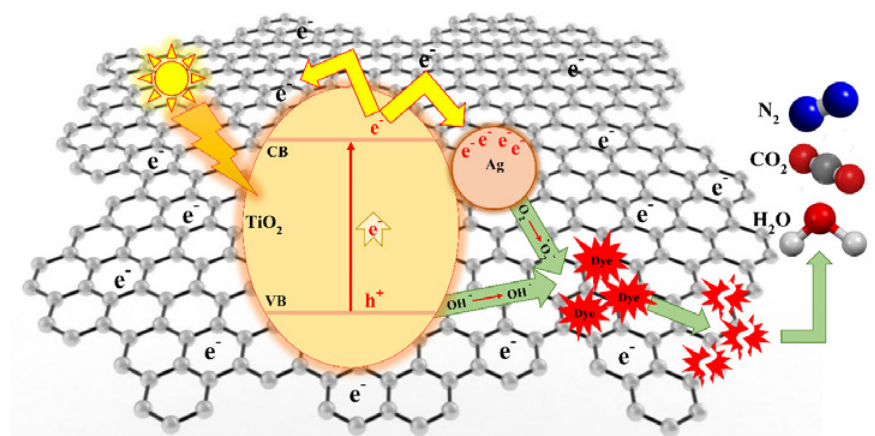
Fig. 9. Schematic for electron transfer between the energy levels of Ag-TiO